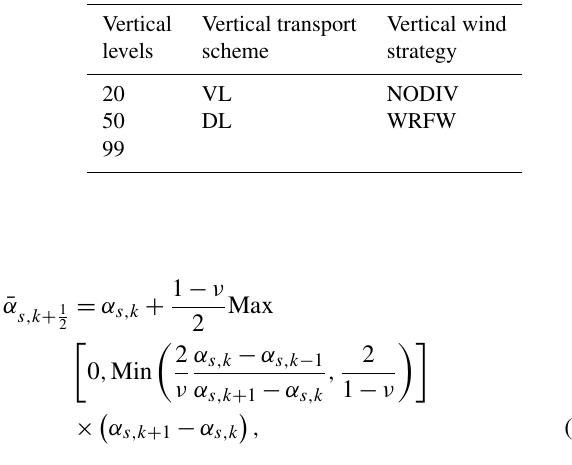
Table 1. List of the various model parameters tested, allowing for a total of 12 distinct simulations to be